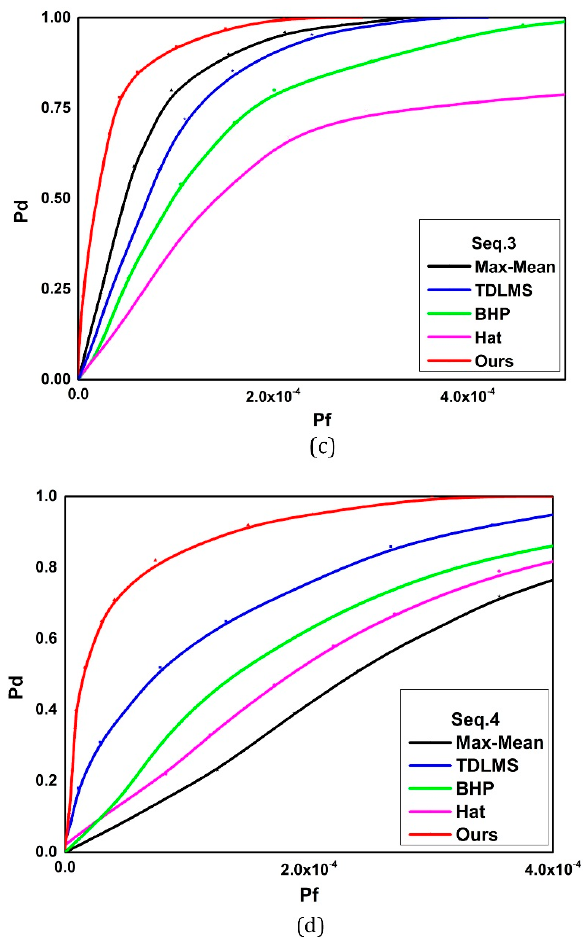
Figure 13. Receiving Operating Characteristic (ROC) curves of the four tested sequences: ( a ) Seq.1, ( b ) Seq.2, ( c ) Seq.3, ( d ) Seq.4.